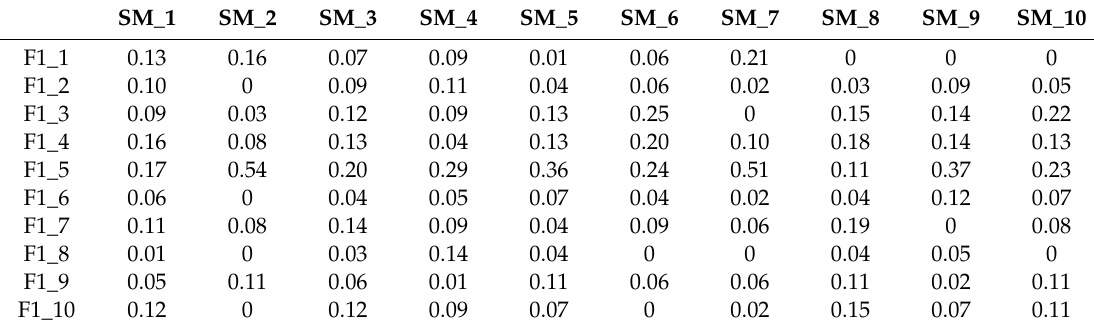
Table 4. Fuzzy probability matrix between the first principal component and the soil